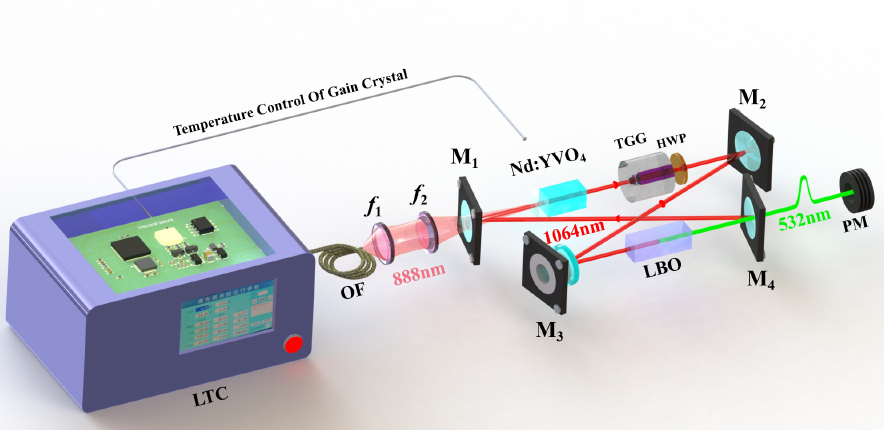
Figure 1. Schematic diagram of high-power single-frequency CW 532 nm laser. LTC, Laser Tempera- ture Controller (Including pump source LD and laser temperature control system); OF, Optical Fibers; f 1 – f 2 , lenses; M 1 –M 4 , mirrors; Nd:YVO 4 , Nd 3 + doped yttrium vanadate; HWP, Half Wave Plate; TGG, Terbium Gallium Garnet; LBO, lithium triborate; PM, Power